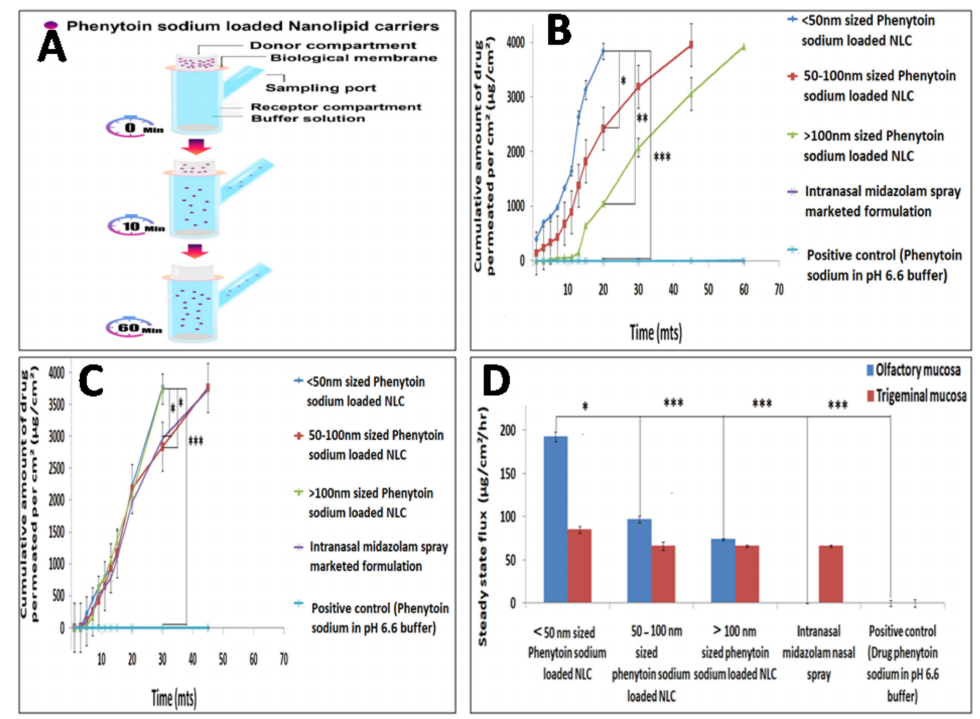
Figure 4. Theschematic representation of ex vivo permeation study of phenytoin sodium NLCs ( A ),